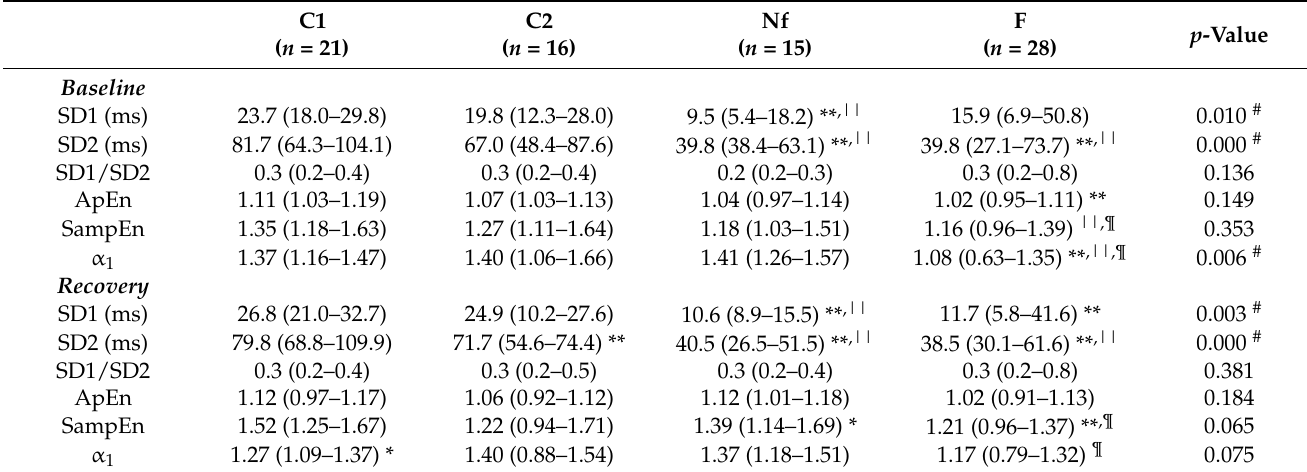
Table 3. Non-linear HRV parameters evaluated from a 160-m walking test in young adults (C1), middle-aged adults (C2), non-frail older adults (nF), and frail older adults. n : number of participants. Data is shown as median (percentile 25 –percentile 75).